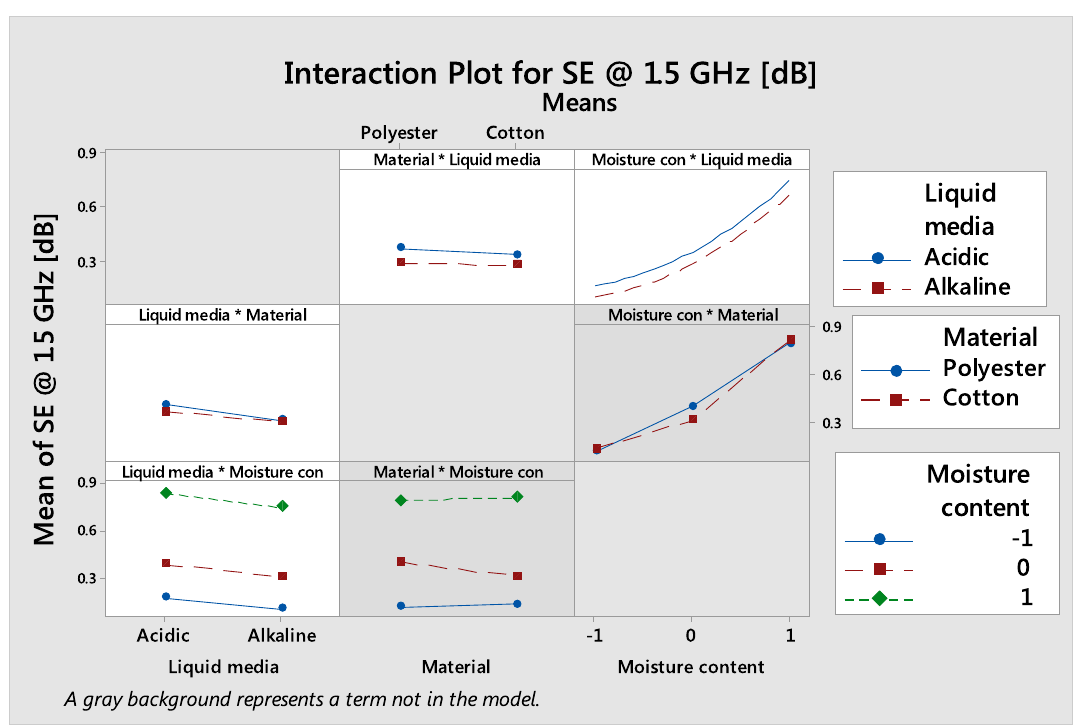
Figure 5. Interaction plots for SE at 1.5